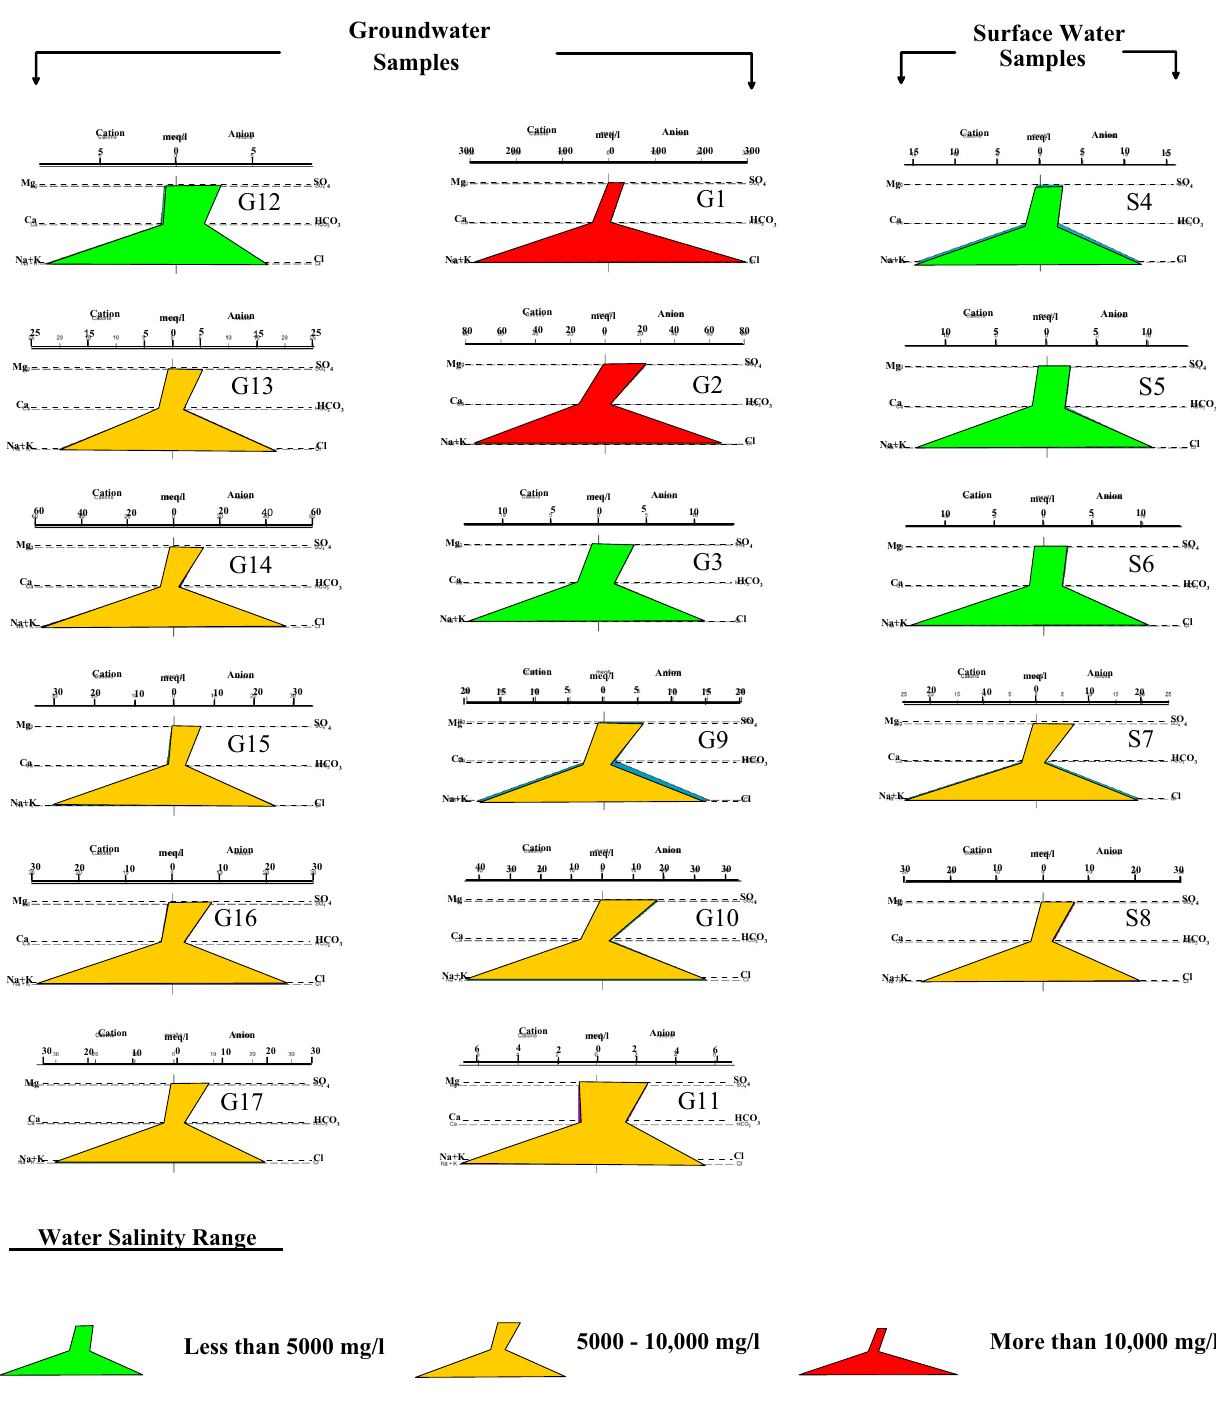
Fig. 4 Distribution of water salinity and Stiff diagram for surface water and groundwater samples collected in December